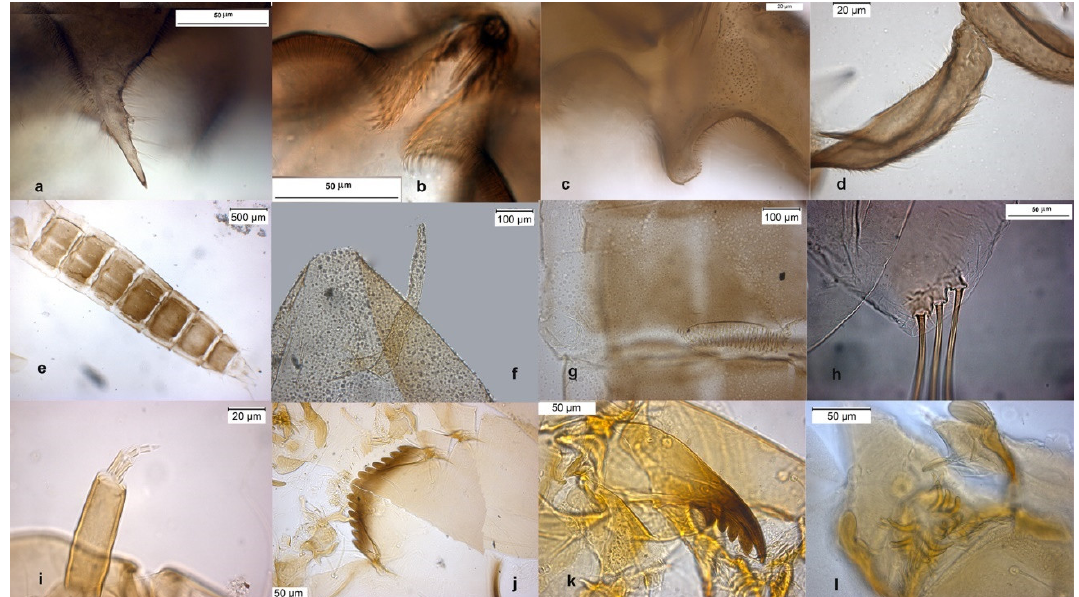
Figure 2. Morphological characters of O. ( O. ) marchettii adult male: ( a ) anal point; ( b ) virga and superior volsella; ( c ) inferior volsella; ( d ) gonostylus; pupal exuvia: ( e ) abdomen; ( f ) thoracic horn, ( g ) tergite II; ( h ) taeniate extensions;